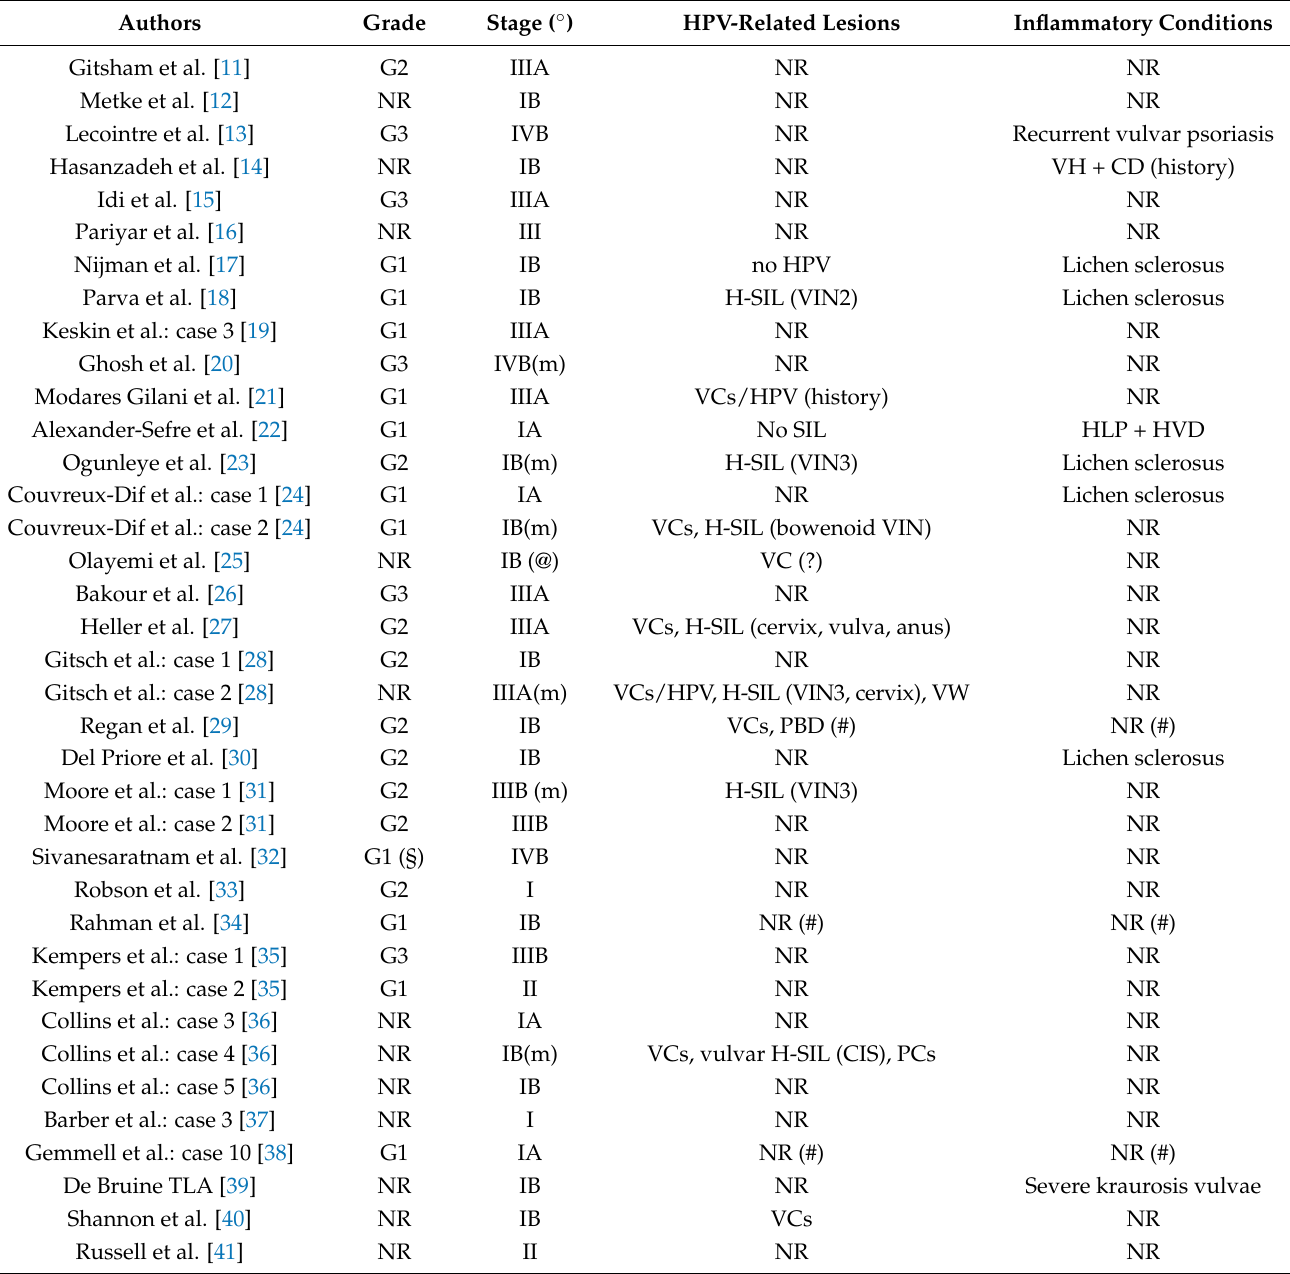
Table 2. Pathological features of vulvar carcinomas and